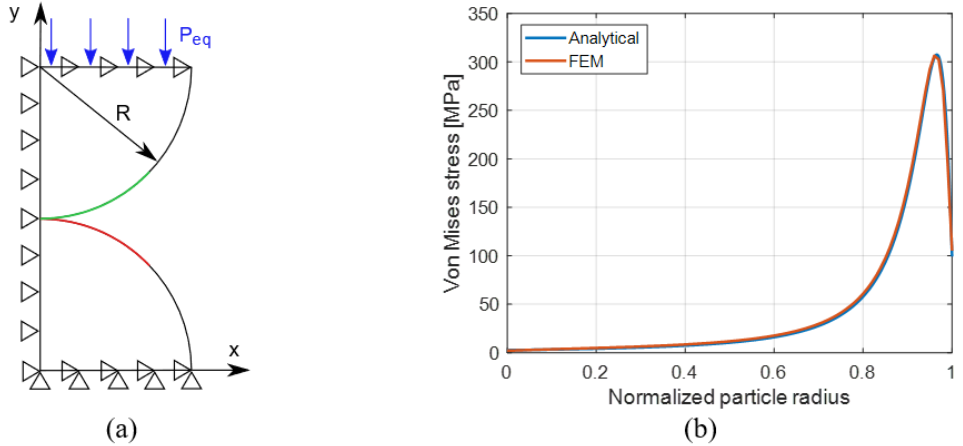
Figure 6. Sketch of the contact model ( a ). Green and red layers are the conta172 and targe169 elements, respectively. Comparison of Von Mises stress computed with FE and analytical model along contact direction (y axis) ( b ). Simulation is carried out with model parameters of Table 2, reaching the percentage amount of lithium K = 20% with a lithium flux of 2 A/m 2 and a simulation time of 350